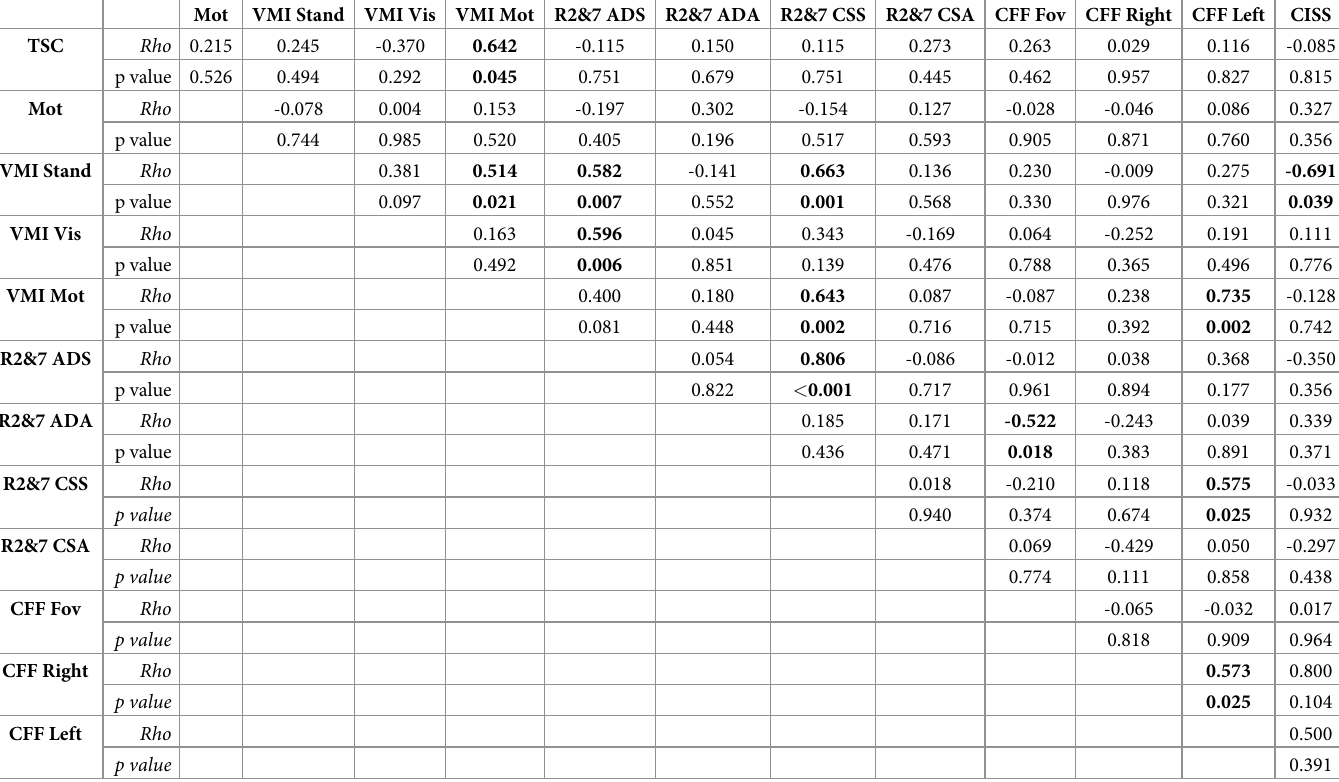
Table 1. Spearman’s Rho correlation